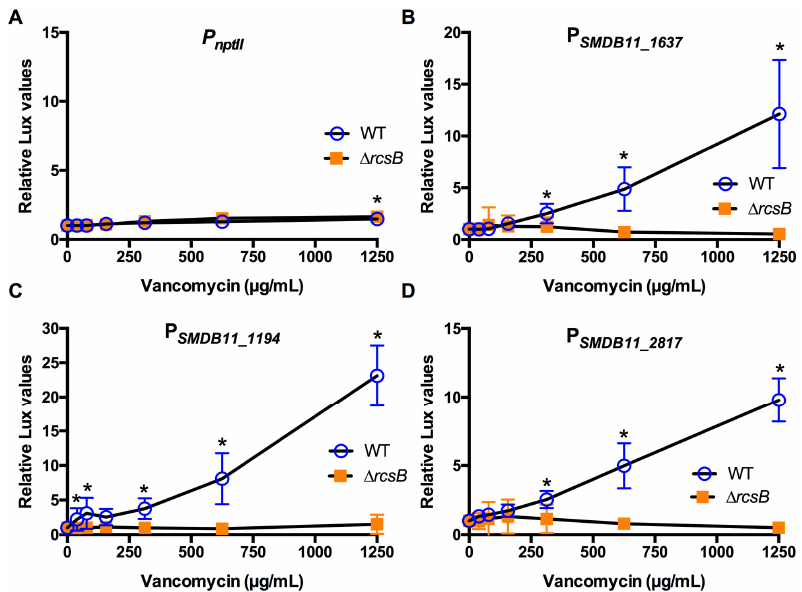
Figure 5. Effect of the cell wall activating antibiotic vancomycin on Rcs-activated promoters ( A – D ). Relative luminescence values were determined by dividing luminescence by optical density after 4 h of antibiotic challenge. The nptII promoter ( A ) was unaffected by vancomycin. The experimental promoters ( B – D ) were activated to a greater extent in the WT than the Rcs-defective ∆ rcsB mutant. Mean and standard deviation are shown ( n = 6–9 are shown). Asterisks (*) indicate statistical differences between groups at the indicated concentrations, p < 0.05.